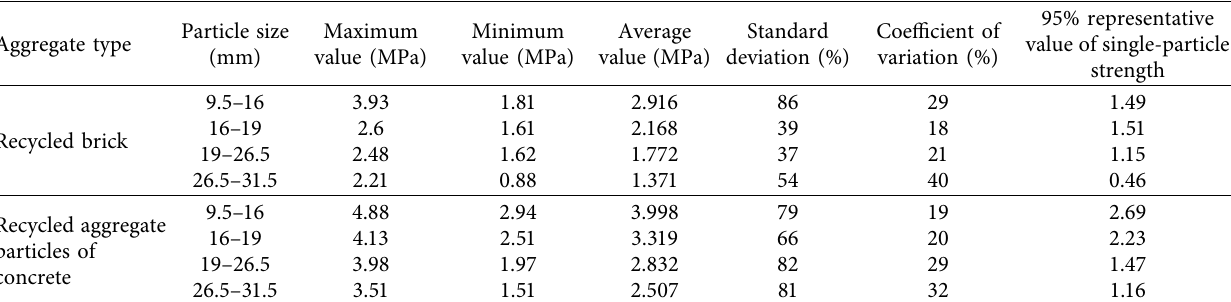
Figure 7: XRD patterns of different recycled aggregate particles. (a) Recycled brick particles. (b) Concrete recycled crushed stone particles. Table 1: 95% guarantee rate representative value of crushing strength of single